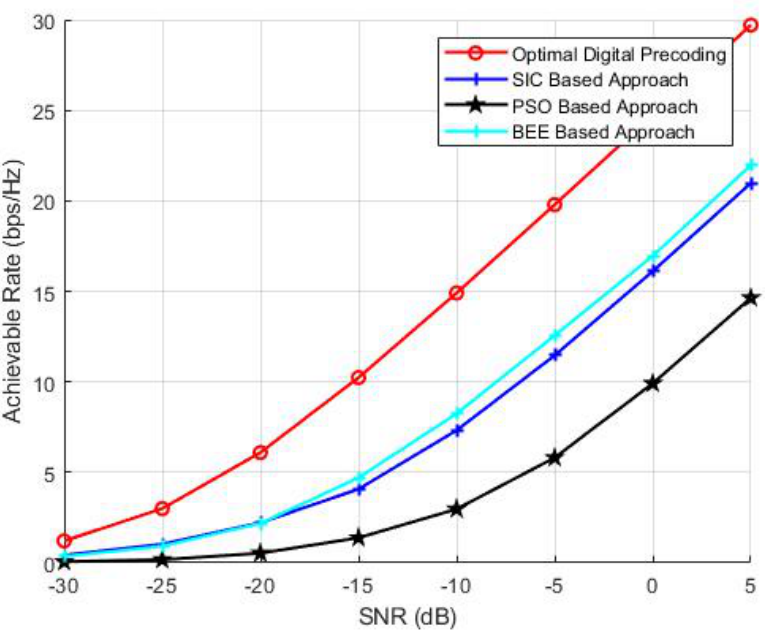
Figure 6. Simulations using N T = 144, N R = 36, N rf = 3.